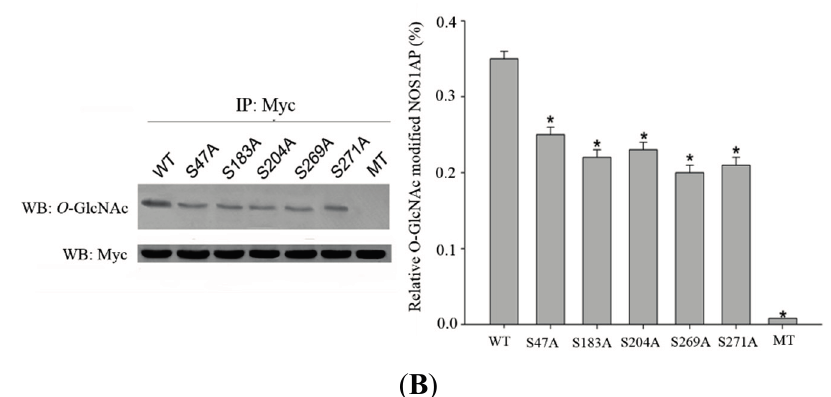
Figure 3. O -GlcNAc Sites on NOS1AP. ( A ) (ETD)-MS analysis indicated O -GlcNAc and phosphorylation modification sites; and ( B ) Different types of Myc-tagged NOS1AP were immunoprecipitated with anti-Myc beads, and immunoblotted for O -GlcNAc. WT represent wild type NOS1AP. Ser47, Ser183, Ser204, Ser269, Ser271 represent single site mutated NOS1AP. MT represent all O -GlcNAc sites mutated NOS1AP. The data are mean ±